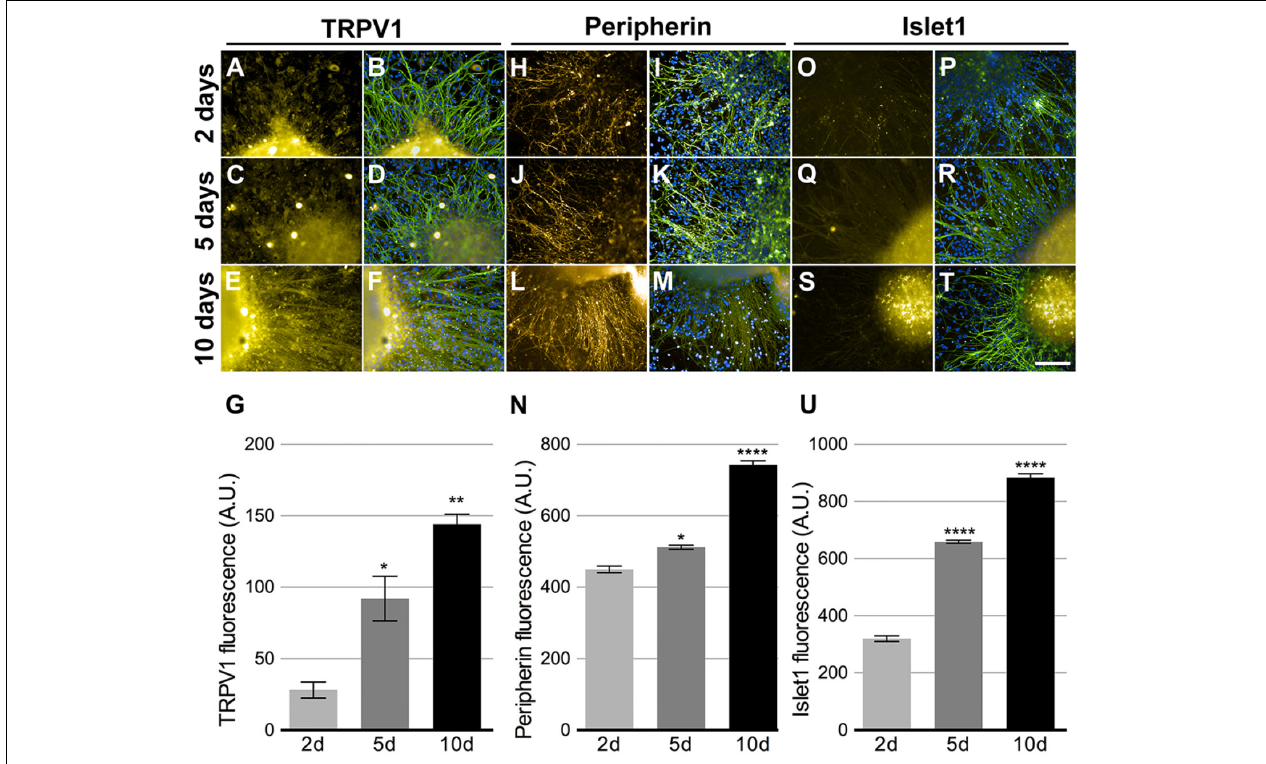
FIGURE 5 | Peripheral sensory neurons maturation. Neurons cultivated in 75% HEKn cells media presented time dependent increase in expression of TRPV1 (A,C,E,G) , Peripherin (H,J,L,N) and Islet-1 (O,Q,S,U) . Beta-tubulin class III (green) and DAPI (blue) were co-stained in all conditions (B,D,F,I,L,K,M,P,R,T) . TRPV1 fluorescence intensity increased by 328 and 514% after 5 and 10 days, respectively (G) ; peripherin showed 118 and 165% increase after 5 and 10 days, respectively (N) and Islet-1 also presented 205 and 276% increase after 5 and 10 days, respectively (U) . One-way ANOVA followed by Tukey’s multiple comparison test, ∗ p < 0.05, ∗∗ p < 0.01, and ∗∗∗∗ p < 0.0001, n = 3 individual experiments from three separate